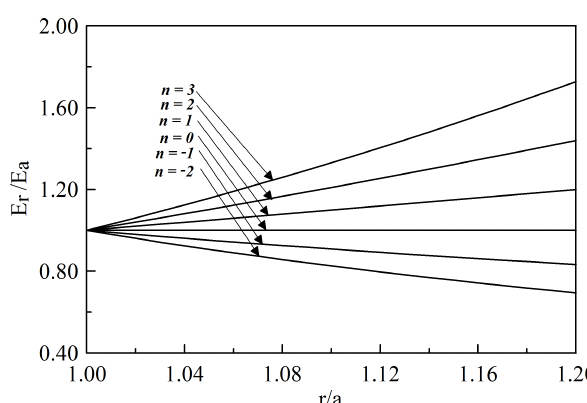
Figure 2: Radially distributed elastic modulus